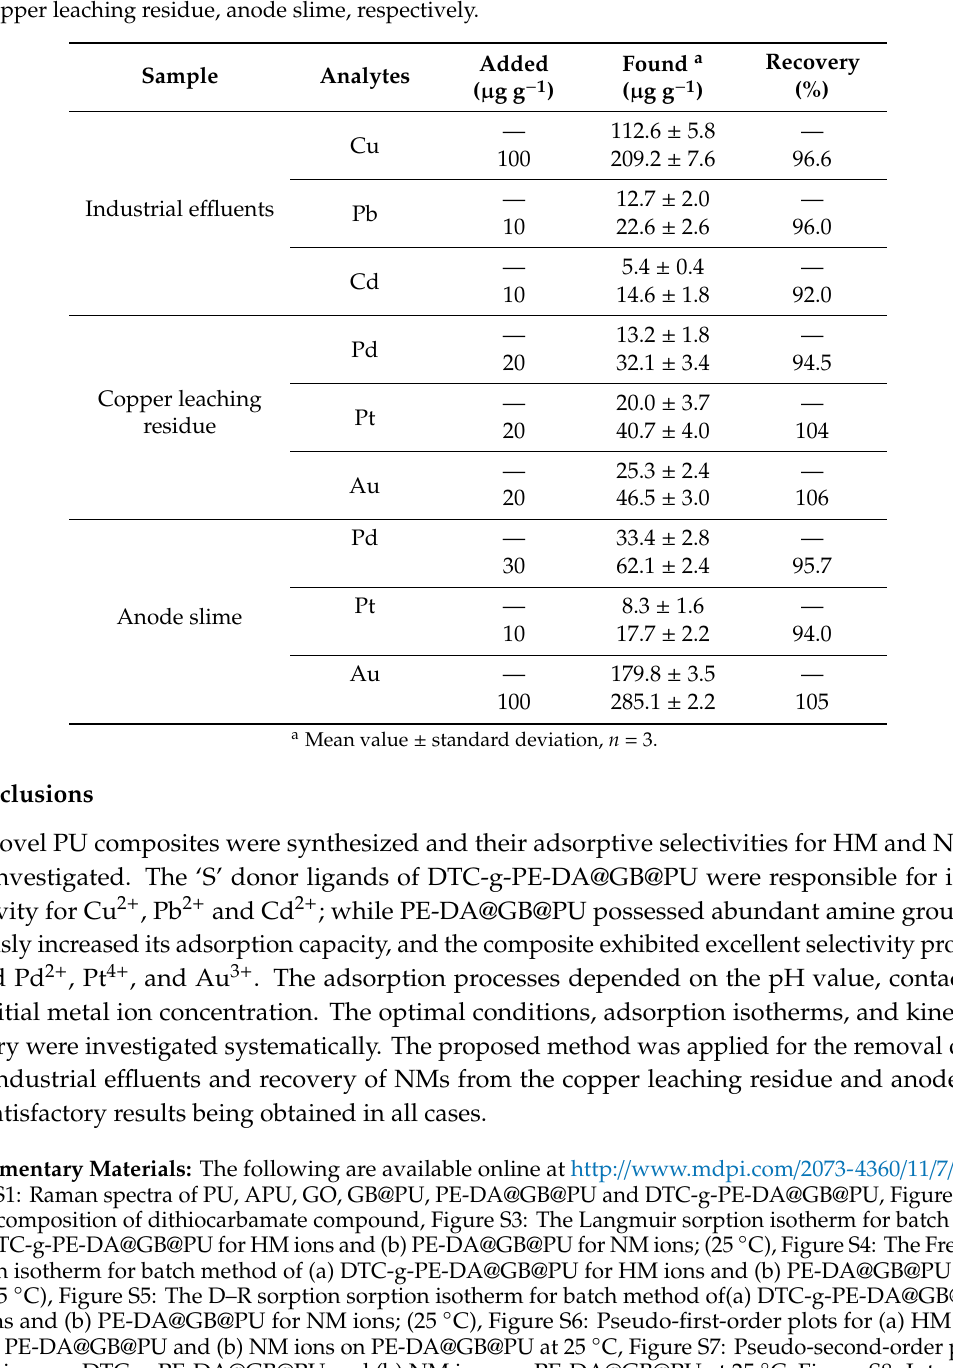
the pH to 6, Table S1: Operation parameters of IRIS Advantage ICP-OES, Table S2: Comparison of the